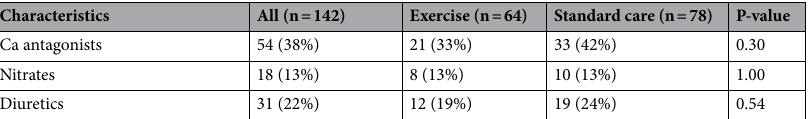
Table 1. Patient characteristics. Continuous variables are presented as means ± standard deviations or as medians with 25th and 75th percentiles; dichotomous variables are expressed as numbers and percentages. HIIT high-intensity interval training, BMI body mass index, CAD history the most severe diagnosis, if the patient has been revascularised multiple times, LVEF left ventricular ejection fraction, CAD coronary artery disease, AMI acute myocardial infarction, PCI percutaneous coronary intervention, CABG coronary artery bypass graft, UAP unstable angina pectoris, NSTEMI non-ST-elevation myocardial infarction, STEMI ST-elevation myocardial infarction, eGFR estimated glomerular filtration rate, LDL-C low-density lipoprotein cholesterol, HDL-C high-density lipoprotein cholesterol, HbA1c Haemoglobin A1c, ASA acetylsalicylic acid, ACE angiotensin-converting enzyme.